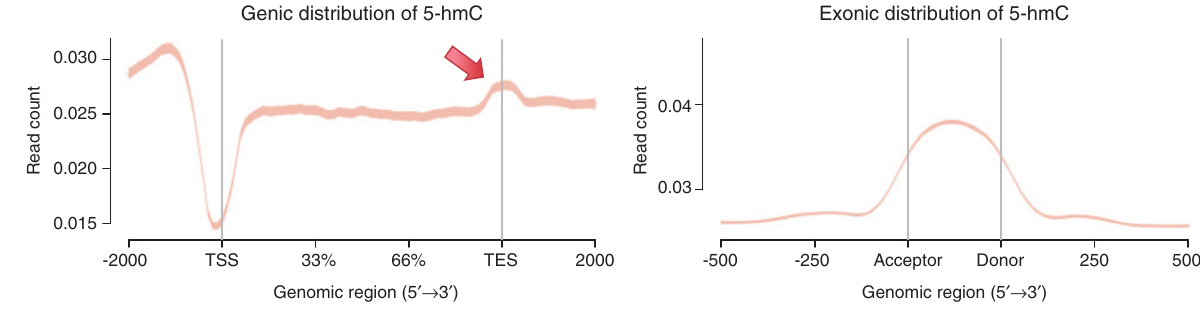
Figure 2: Genic and exonic distribution of 5-hmC in brain. Using antibodies specific for 5-hmC combined with a MeDIP-Seq method optimized for Ion Torrent sequencing, we measured the distribution of 5-hmC in postmortem human brain tissue. Reads from the sequenced library were mapped to the hg19 reference genome and read count (per million mapped reads) is displayed ± 2 kb over TSS, gene bodies, and TES (left panel) and over canonical exons (right panel). Arrow highlights area of 5-hmC enrichment at TES. Adapted from Ref.